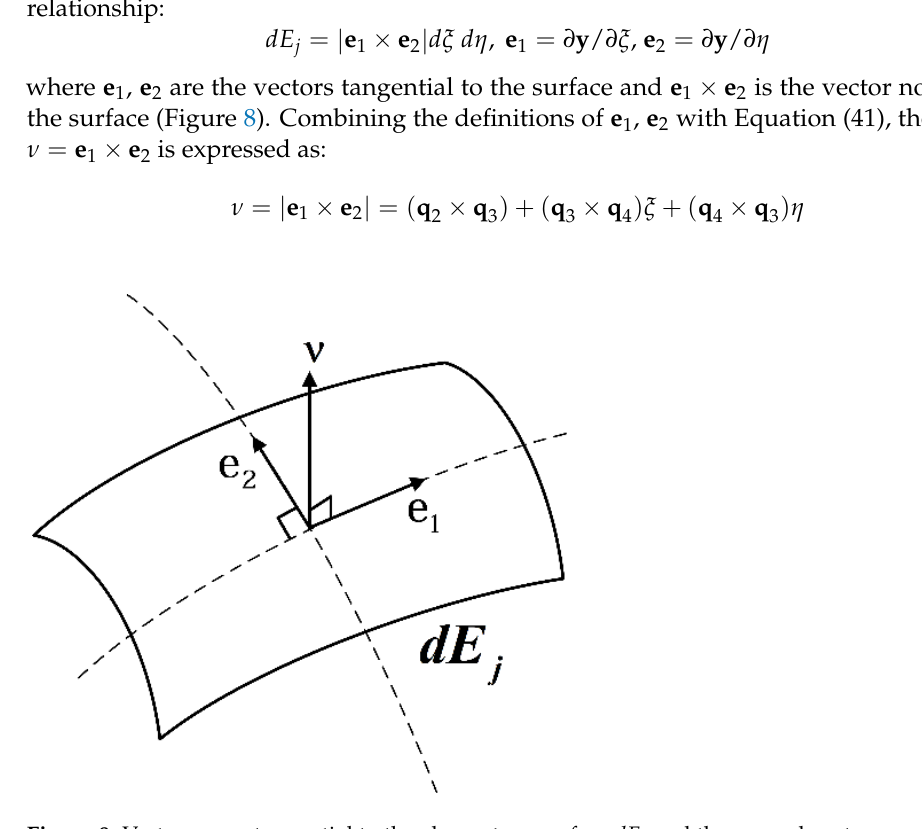
Figure 8. Vectors Figure 8. Vectors e 1 , e 2 tangential to the elementary surface dE j and the normal vector ν = e 1 × e 2